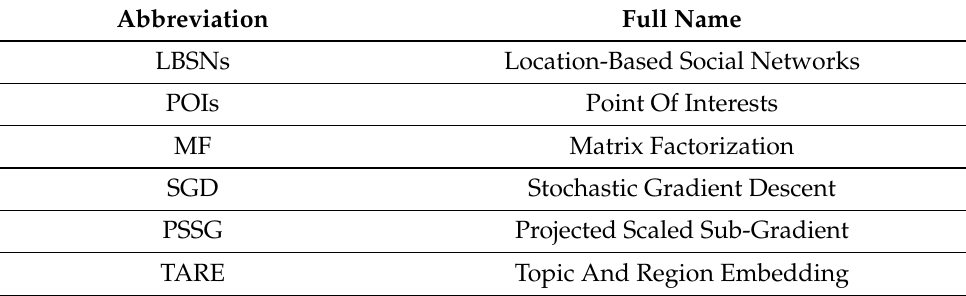
Table 2. The abbreviation and full name of concepts.